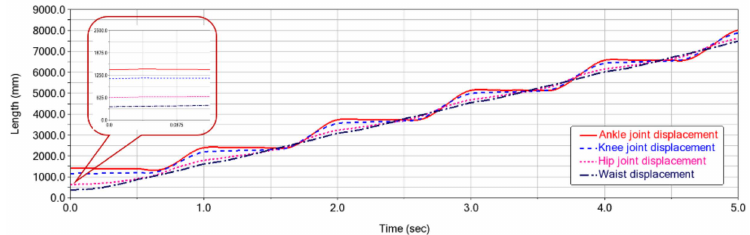
Figure 28. Displacement of each joint of lower-limb exoskeleton robot